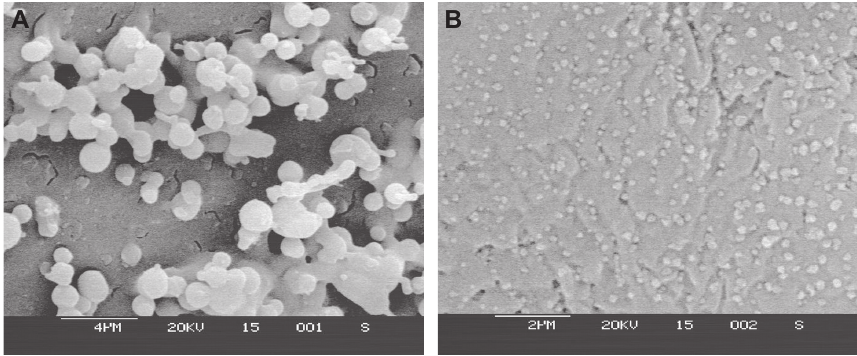
Figure 4 The effect of PVA content on morphology of